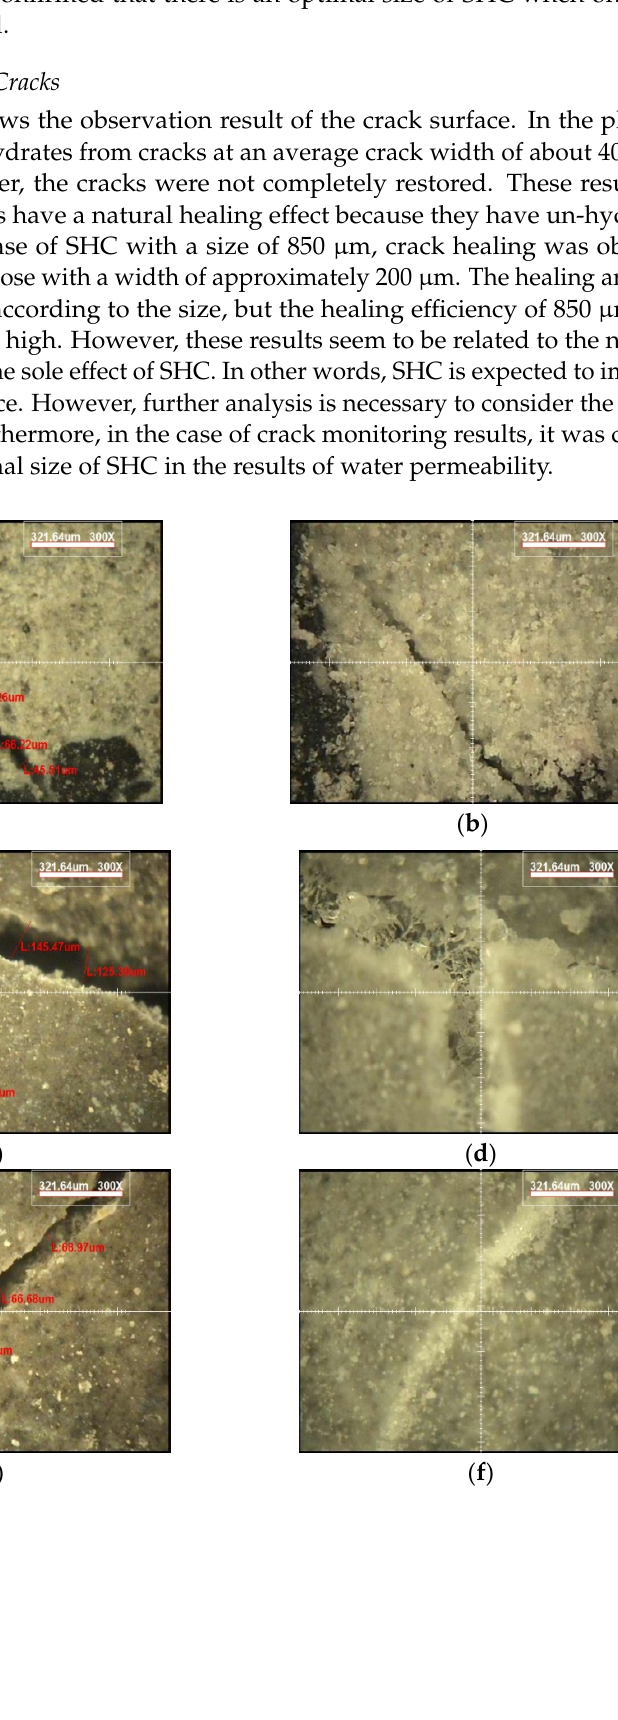
Figure 11. Test results of water permeability.